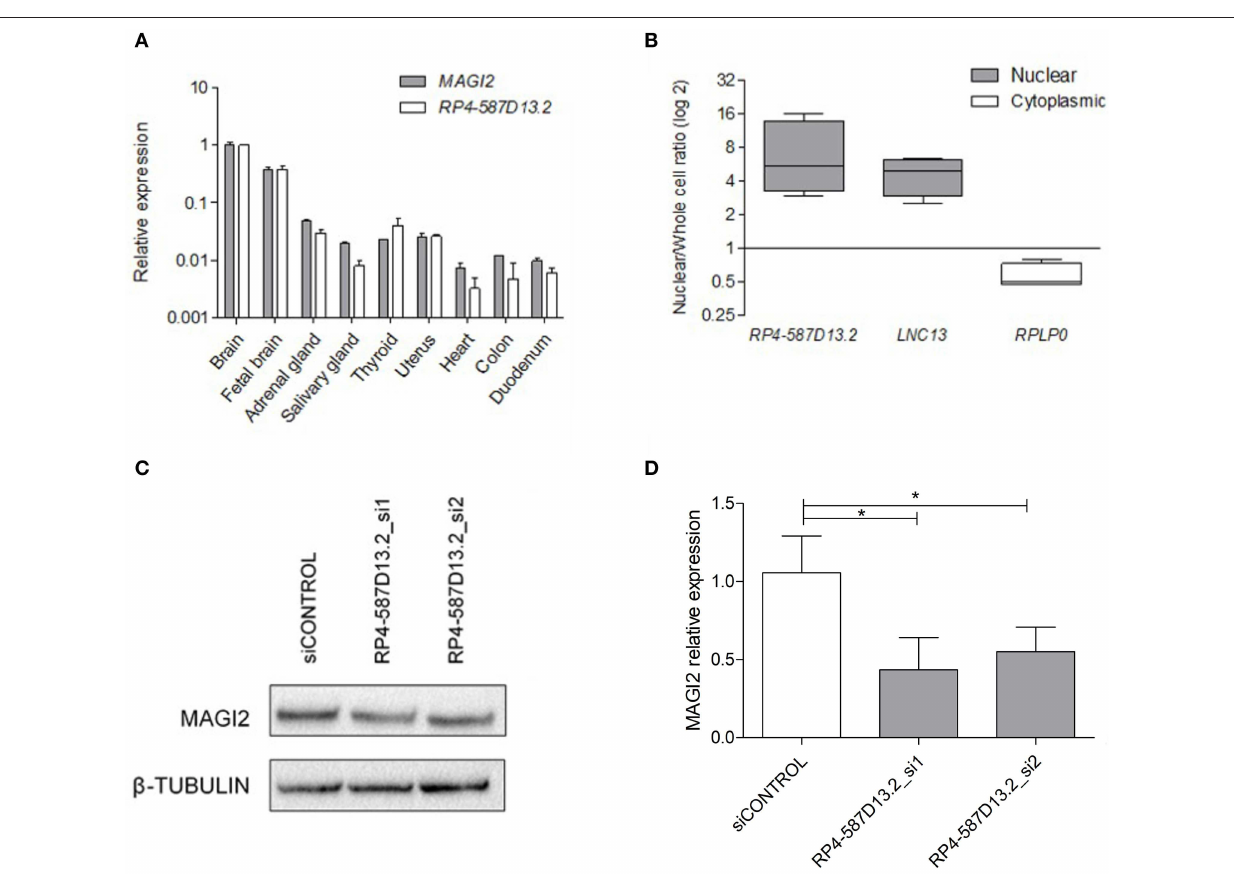
causing alterations in gene regulation. An analysis of current UCSC Genome browser annotations showed that protein- coding gene MAGI2 hosts different types of non-coding genes,